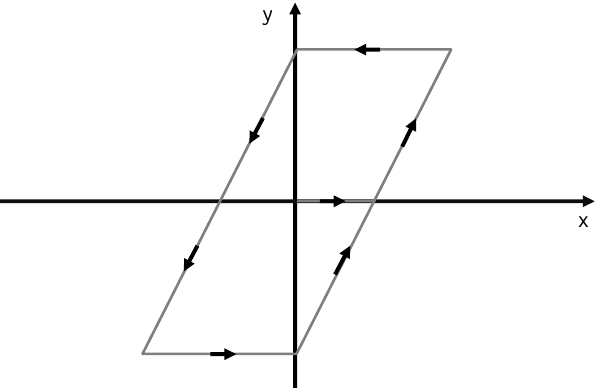
Figure 5. Play operator